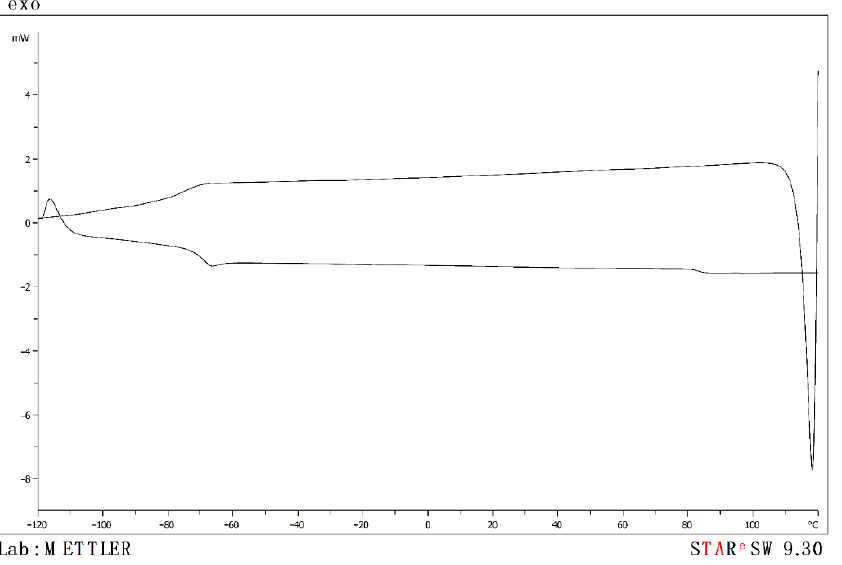
Figure 4. Experimental molar heat capacities, Cp, as a function of temperature for the equimolar binary mixtures: ( ○ ) (1,3) BMimTFO + (1,3) BMimNTf 2 ; ( □ ) (1,3) BMimDCA + (1,3) BMimNTf 2 ; ( ▲ ) (1,3) BMpyTFO + (1,3) BMpyNTf 2 ; ( ● ) (1,1) BMpyrTFO + (1,1) BMpyrNTf 2 and ( ■ ) (1,1) PMpipTFO + (1,1) PMpipNTf 2 , solid lines represent the fitting using the Equation (2).